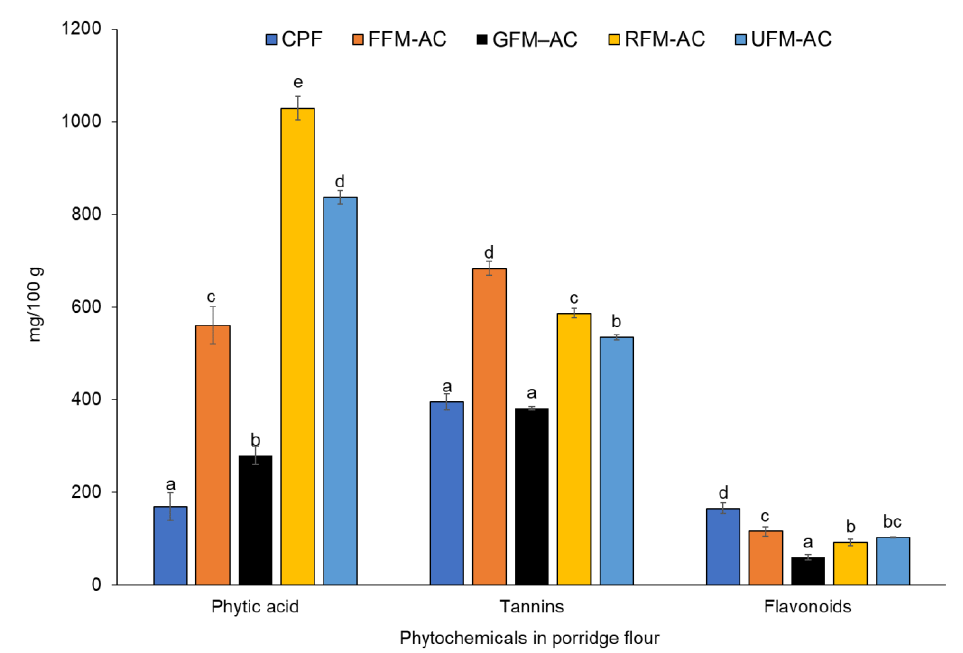
Figure 3. Bar graphs represent mean and error bar standard deviation of phytochemical content in the flour samples. Different letters above the error bar indicate significant differences in phytochemical content. CPF = commercial porridge flour; FFM–AC = fermented finger millet − amaranth + cricket; GFM–AC = germinated finger millet − amaranth + cricket; RFM–AC = roasted finger millet − amaranth + cricket; and UFM–AC = unprocessed finger millet − amaranth + cricket. mg tannic acid equivalents (TAE)/100 g of sample, mg catechin equivalents (CEQ)/100 g of dry sample.